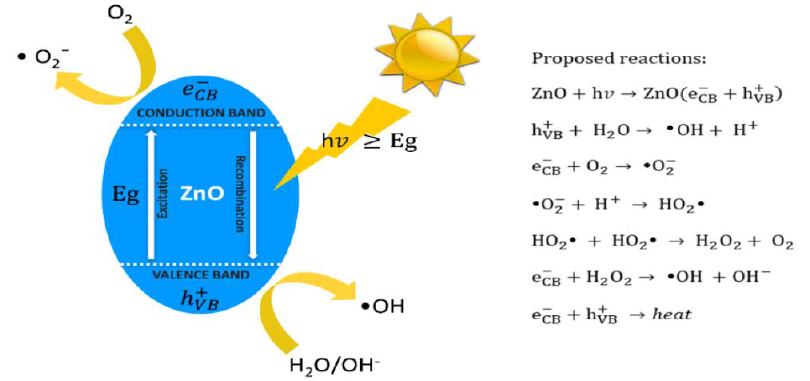
Figure 2. Schematic representation showing the creation of reactive oxygen species on ZnO by irradiating with photons ( hv ) having energies ≥ E g . Proposed photocatalytic reactions are listed in the right panel. Reproduced from [26] permission under the conditions of the Creative Commons Attribution (CC BY)